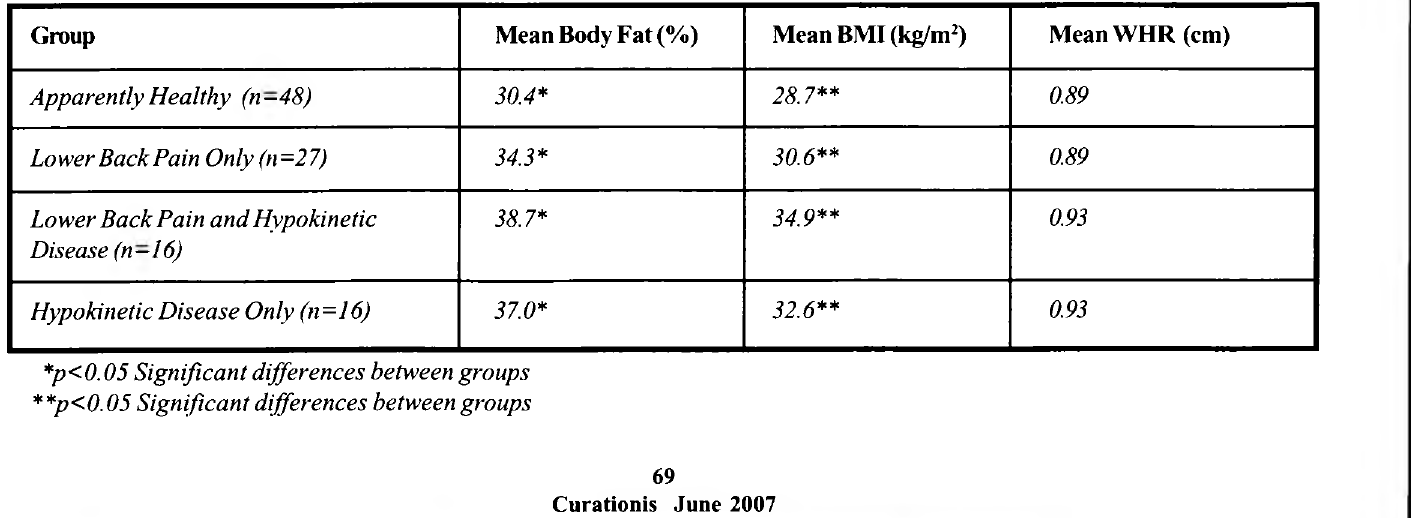
Table 3 Mean percentage body fat, body mass index and waist-to hip